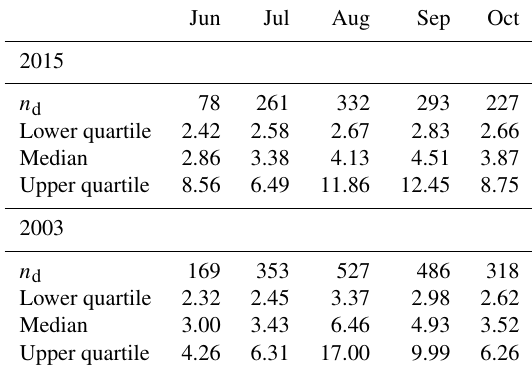
Table 1. Statistical summary of stations under drought for the indi- vidual months of 2015 (top) and 2003 (bottom). The symbol n d is the number of stations under drought (i.e., with a severity of an an- nual low flow event and more). Median and quartiles summarize the return periods of low flow discharge MM(7) (monthly magnitude) of these stations (expressed as the corresponding return period in the annual extreme-value distribution of the entire